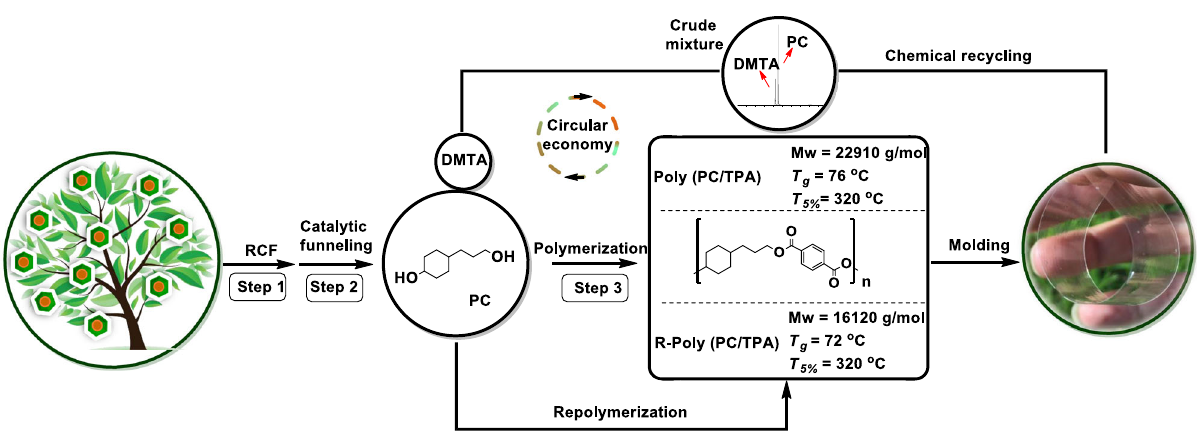
Fig. 6 A circular economy strategy for plastic recycling. Step 1: RCF of lignocellulose over previously developed Cu20-PMO catalyst; Step 2: Catalytic funneling of RCF crude mixture over Raney Ni catalyst using isopropanol as solvent.; Step 3: The copolymerization of PC with DMTA to give poly (PC/TPA) using Zn(OAc) 2 catalyst; One-pot methanolysis of poly (PC/TPA) to recycle monomers PC and DMTA; The crude mixture from depolymerized poly (PC/ TPA) was repolymerized using Zn(OAc) 2 catalyst to give -poly